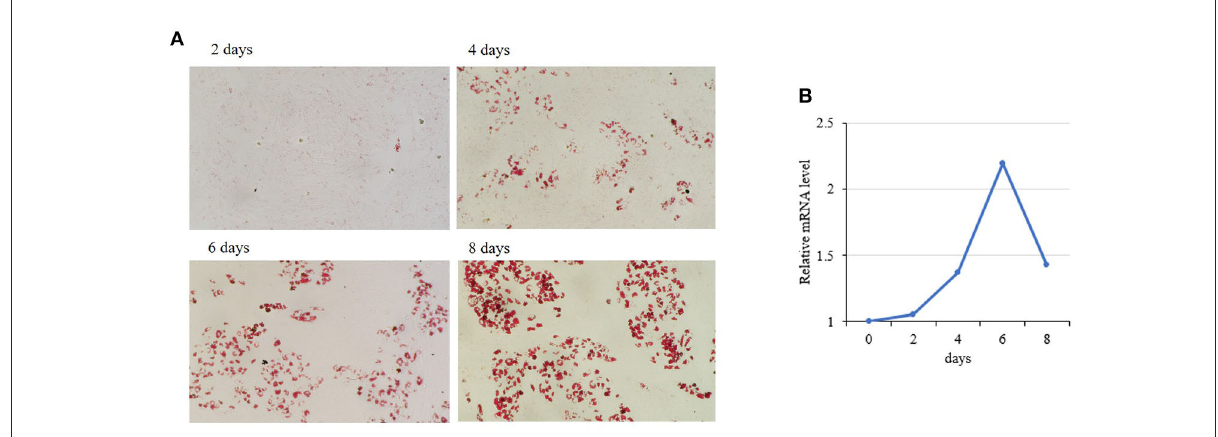
FIGURE4 Expression of porcine CREB1 during differentiation of preadipocytes. (A) Oil Red O staining of preadipocytes during differentiation induction; (B) relative mRNA level of CREB1 during differentiation of preadipocytes.